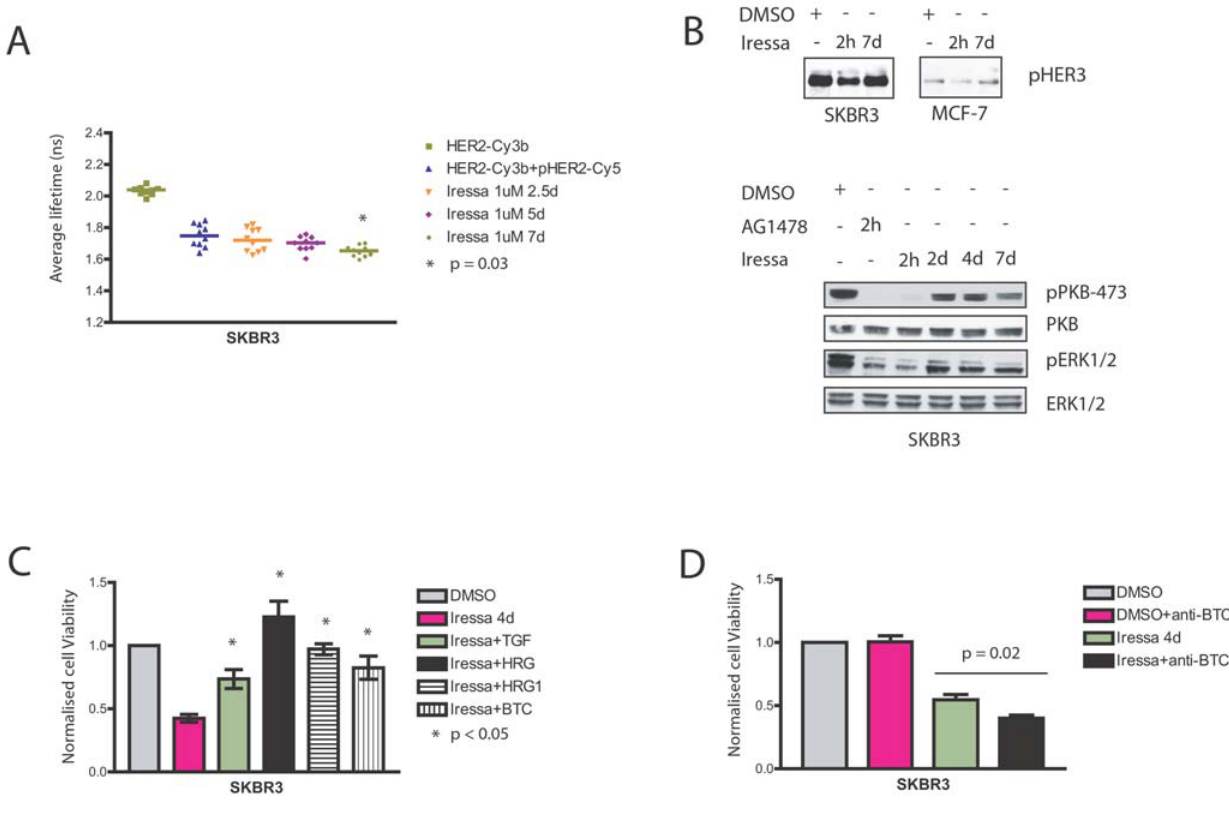
Figure 3. HER2 activation is maintained in surviving SKBR3 cells with reactivation of HER3 and downstream signalling pathways via the autocrine ligand release. A, SKBR3 cells were assessed for HER2 phosphorylation by FRET (see Methods) after the cells were treated with 1 m M Iressa for different durations. B, In the upper panel, SKBR3 and MCF-7 cells were lysed after treatment with either DMSO or 1 m M Iressa for the durations shown and the phosphorylation state of HER3 on Tyr1289 was determined using phosphospecific antibody. In the lower panels, SKBR3 cells were lysed after treatment with either DMSO, 3 m M AG 1478 or 1 m M Iressa for the durations illustrated. Phospho-PKB, phospho-MAPK and the total levels of PKB and Erk1/Erk2 were assessed using appropriate the antibodies. C, Cell viability experiments with SKBR3 cells were performed after treatment with DMSO or 1 m M Iressa with or without growth factors for 4 days. In the first condition DMSO was used as a vehicle control. In other conditions 1 m M Iressa was utilised alone or together with 100 ng/ml TGF, 100 ng/ml heregulin b , 100 ng/ml heregulin b -1 or 20 ng/ml betacellulin. The viable cells were counted in a cell viability analyzer after 4 days using Trypan Blue to stain dead cells. D, SKBR3 cells were treated with 20 m g/ml of anti-betacellulin, Iressa alone or Iressa in combination with 20 m g/ml of anti-betacellulin for 4 days before the cells were counted in a cell viability analyzer. DMSO was used as a vehicle control.